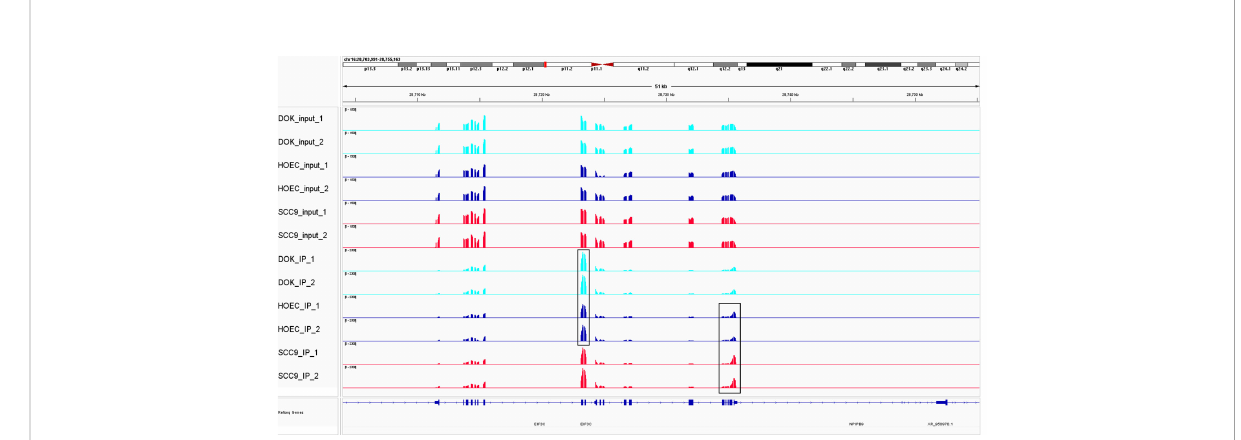
FIGURE 2 The change of m 6 A modi fi cation in DOK and SCC-9 cells compared with HOEC cells. m 6 A peak clusters from three cells are shown along the length of the EIF3C transcript. Compared with HOEC cells, hyper-methylated peaks were observed in exonic region in DOK cells and in 3`UTR in SCC-9 cells. EIF3C, eukaryotic translation initiation factor 3 subunit C.